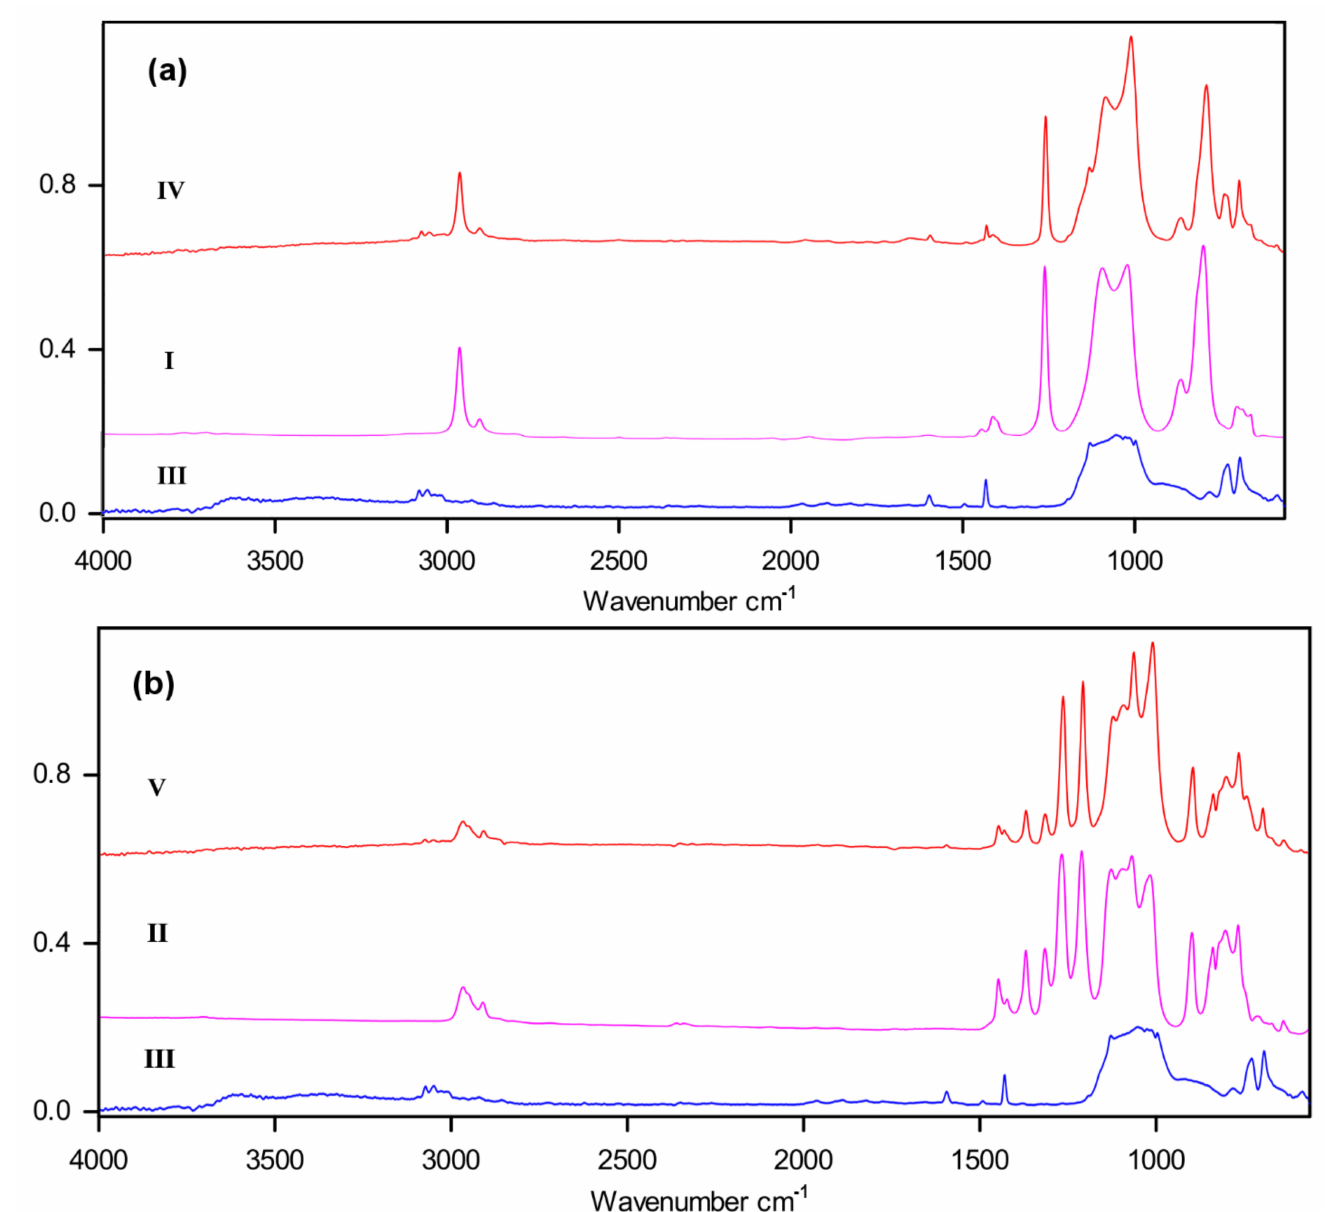
Figure 1. IR spectra of I, III, IV ( a ) and II, III, V ( b